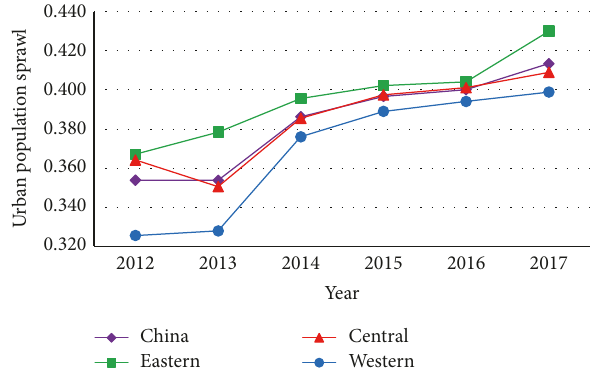
Figure 2: Urban population sprawl in China during 2012-2017.